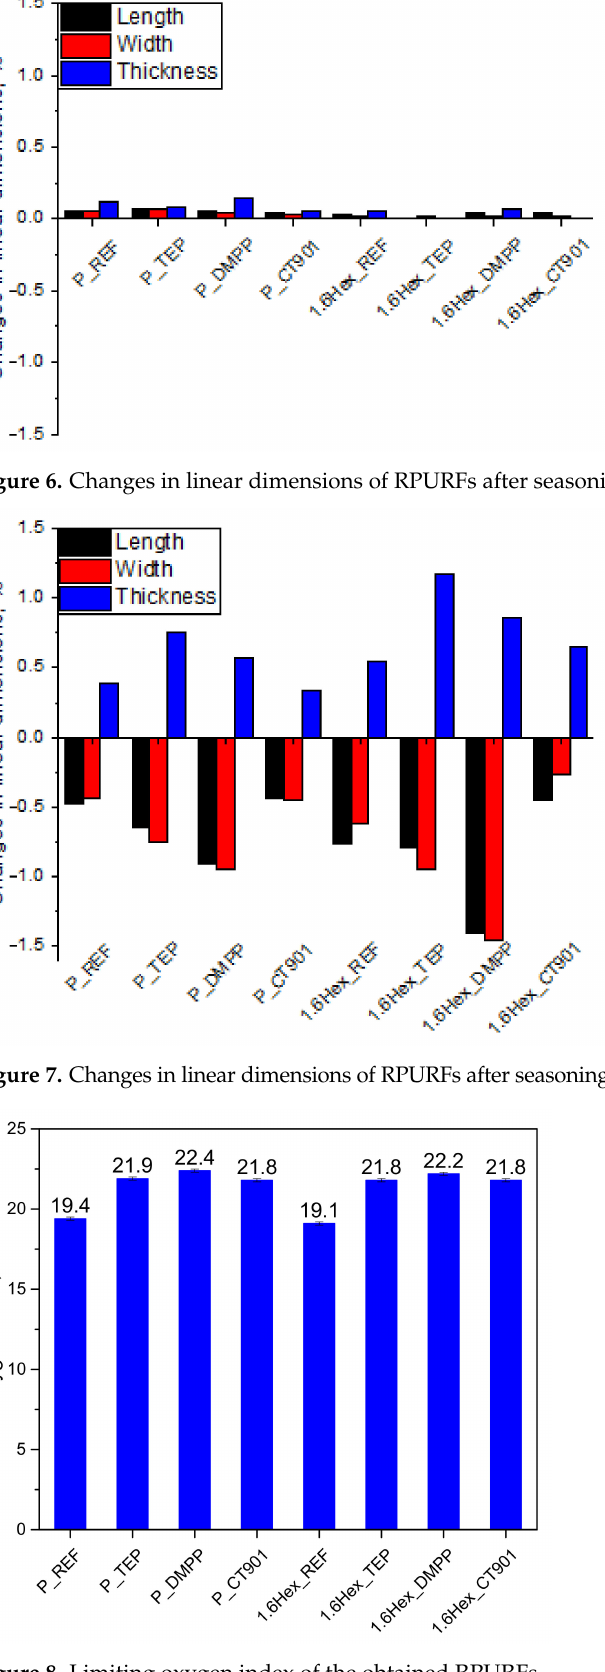
Figure 8. Limiting oxygen index of the obtained